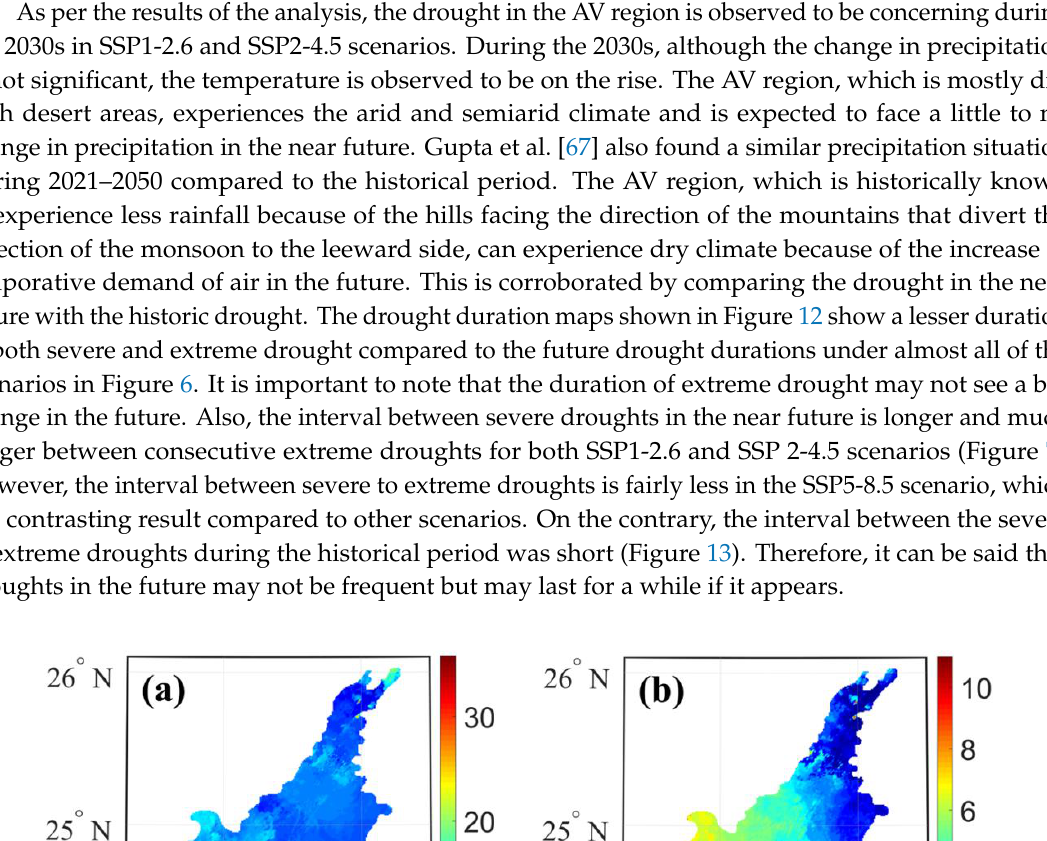
Figure 13. Grid averaged scPDSI values from 1985 to 2014 for study area AV based on historic observed data. The future drought duration, as shown in Figure 8, is expected to increase in BK compared to the drought in the historic period. The increase in the drought duration is observed under all the scenarios but more significantly for the severe drought. The area of spread is also observed to be increasing in the near future compared to the historical period in SSP1-2.6 and SSP5-8.5 scenarios. More precisely, the increase in both the duration and the areal spread is more significant in the severe drought compared to the historical period, as shown in Figure 14. Bisht et al. [68] also exhibited an increase in Indian regions in terms of drought occurrences and the drought durations in the near future. The future drought situation can be attributed to increasing water stress under warming scenarios, which can further be related to higher evaporative demand. Further, the BK region lies in the humid subtropical region, and a rather insignificant increase in precipitation can be observed (Figure 3), and this insignificant increase in precipitation can be attributed to due to anthropogenic aerosol emissions according to Bollasina et al. [69]. However, due to the humid climate, the number of droughts faced in the near future may be frequent but not as frequent and sporadic as in the historical period (Figure 15). Similarly, Mishra et al. [70] stated that yearly variability due to sea surface temperature in the Indian Ocean could end up causing droughts in the Gangetic Plain, within which BK lies.